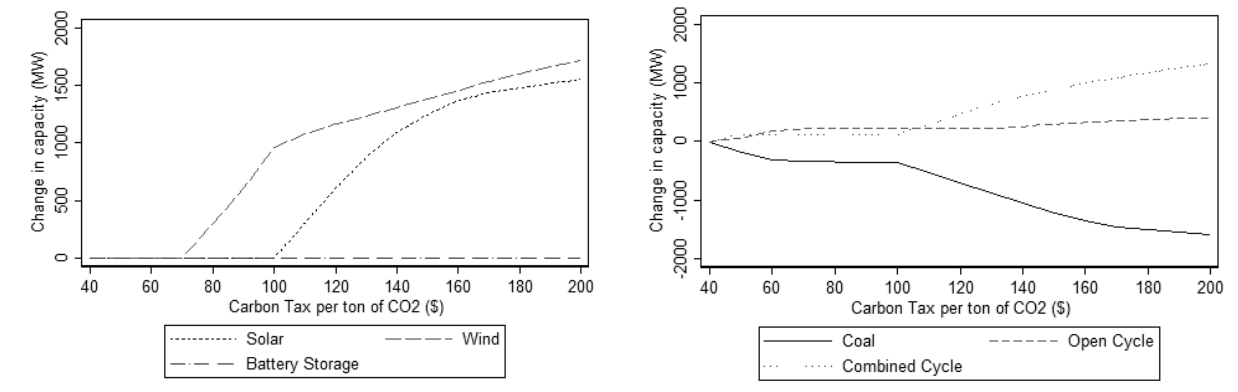
Figure 6. The changes in capacities (MW) with increasing carbon tax.